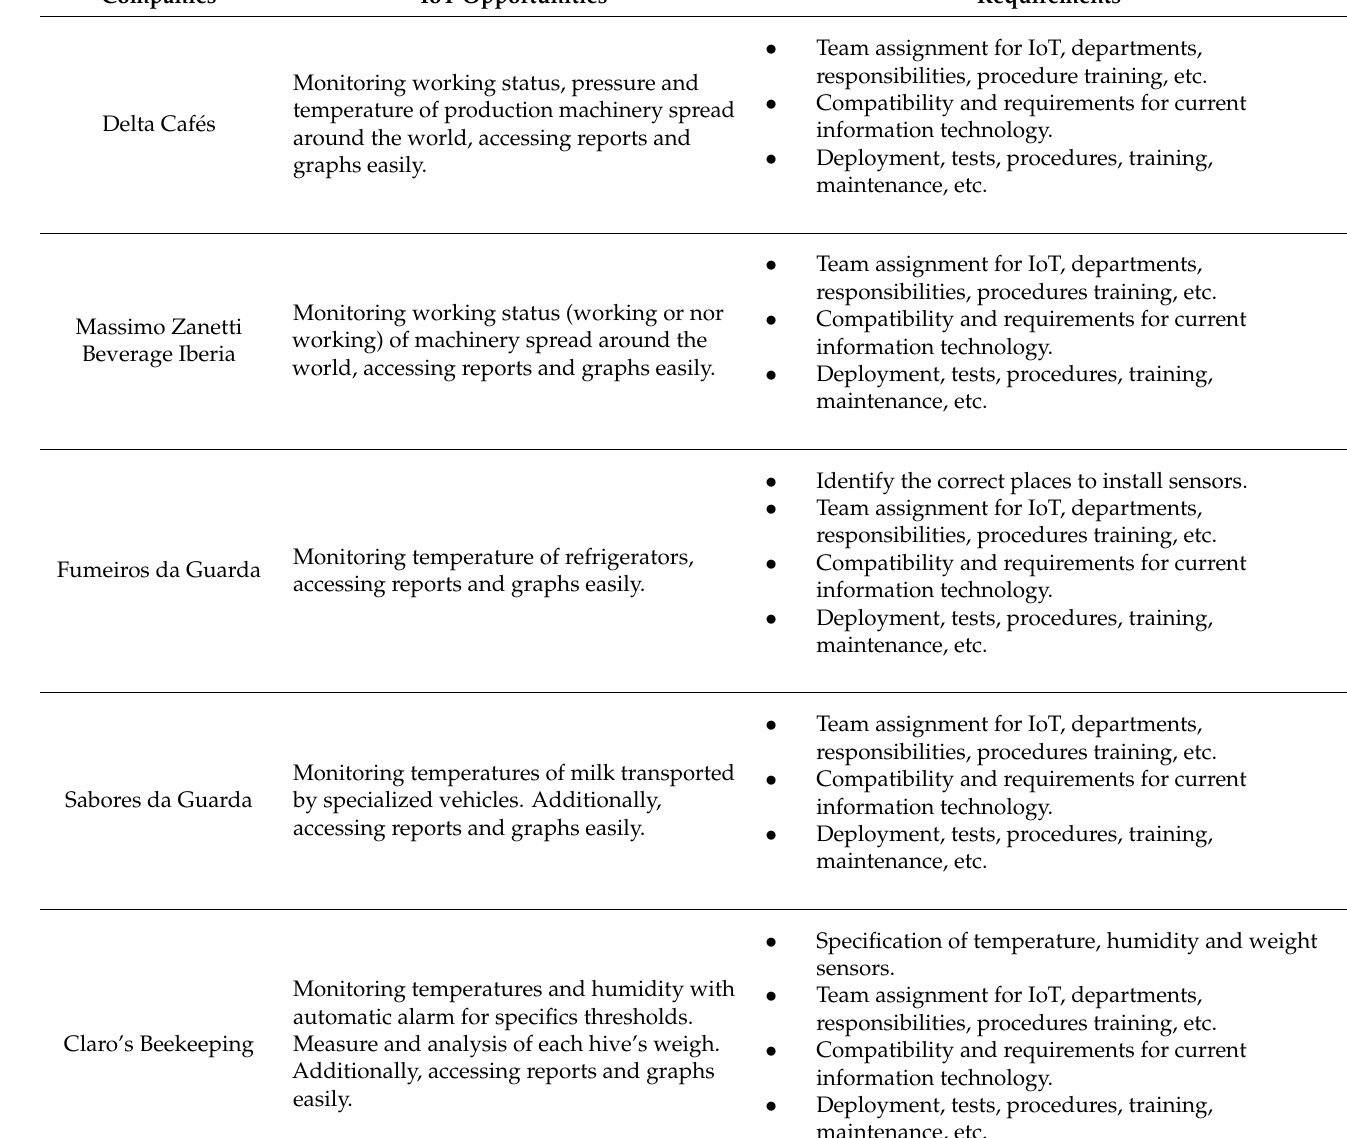
Table 8. Opportunities and requirements for the implementation of IoT according to each company.